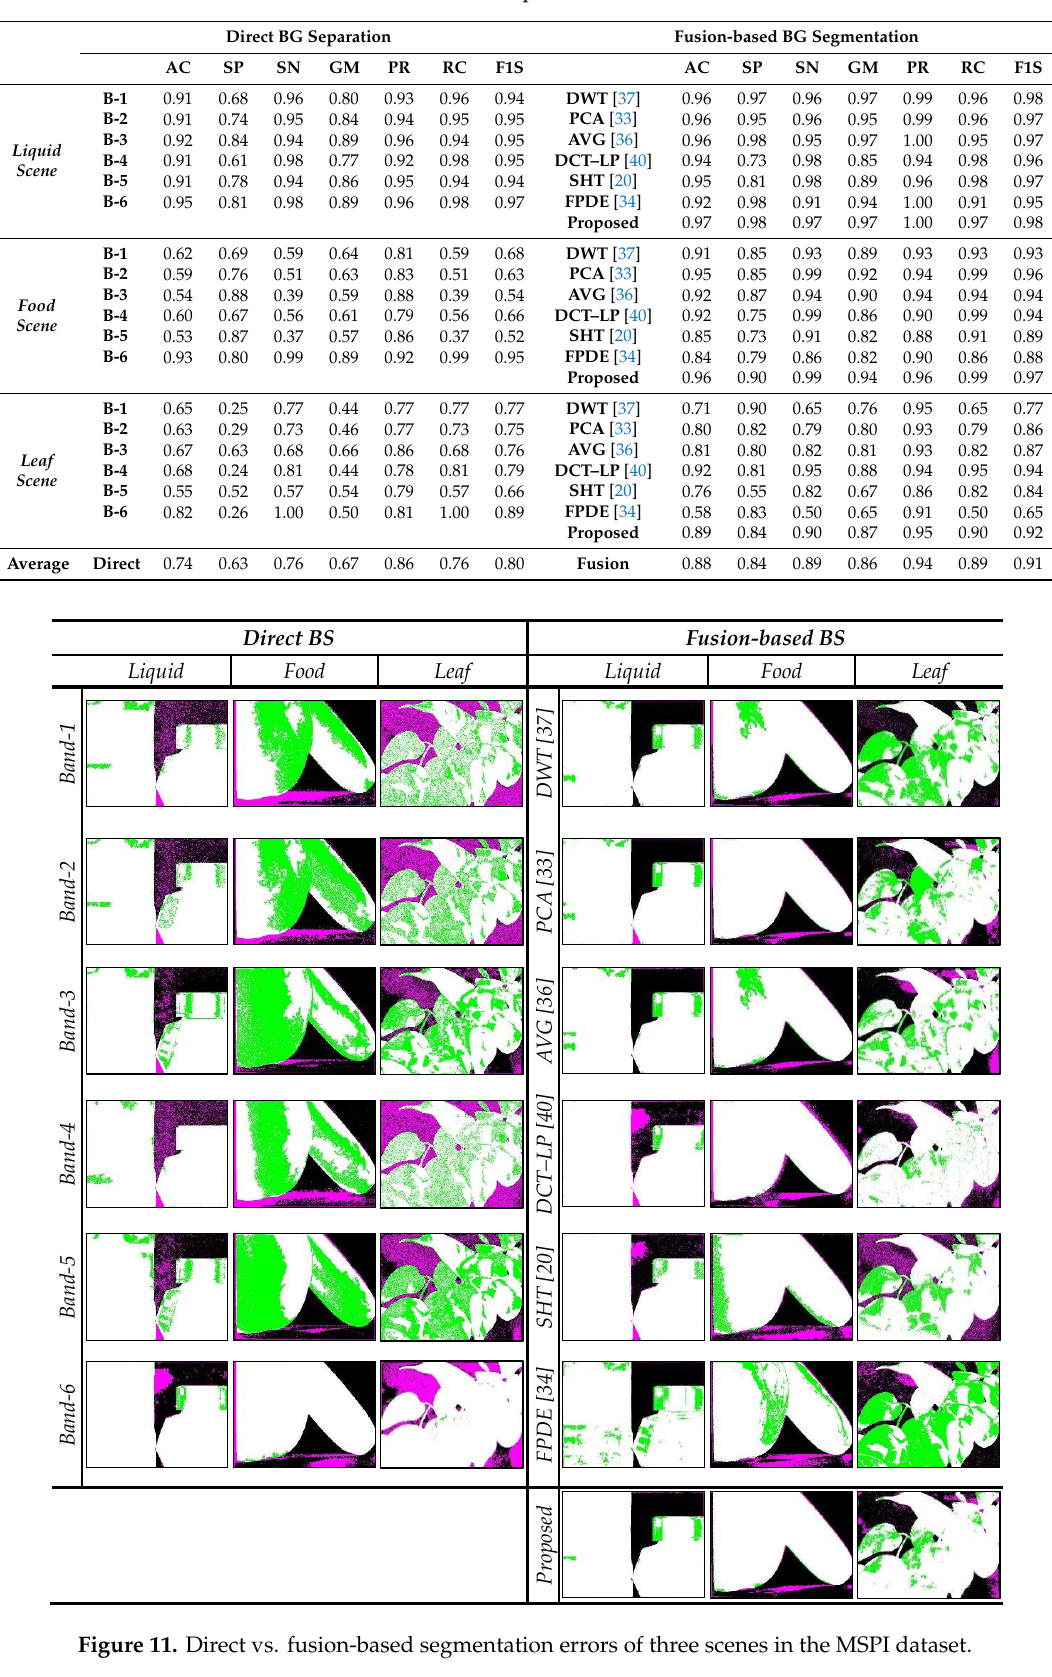
Table 2. Evaluation of direct- vs. fusion-based BS performances for three scenes in the MSPI dataset.